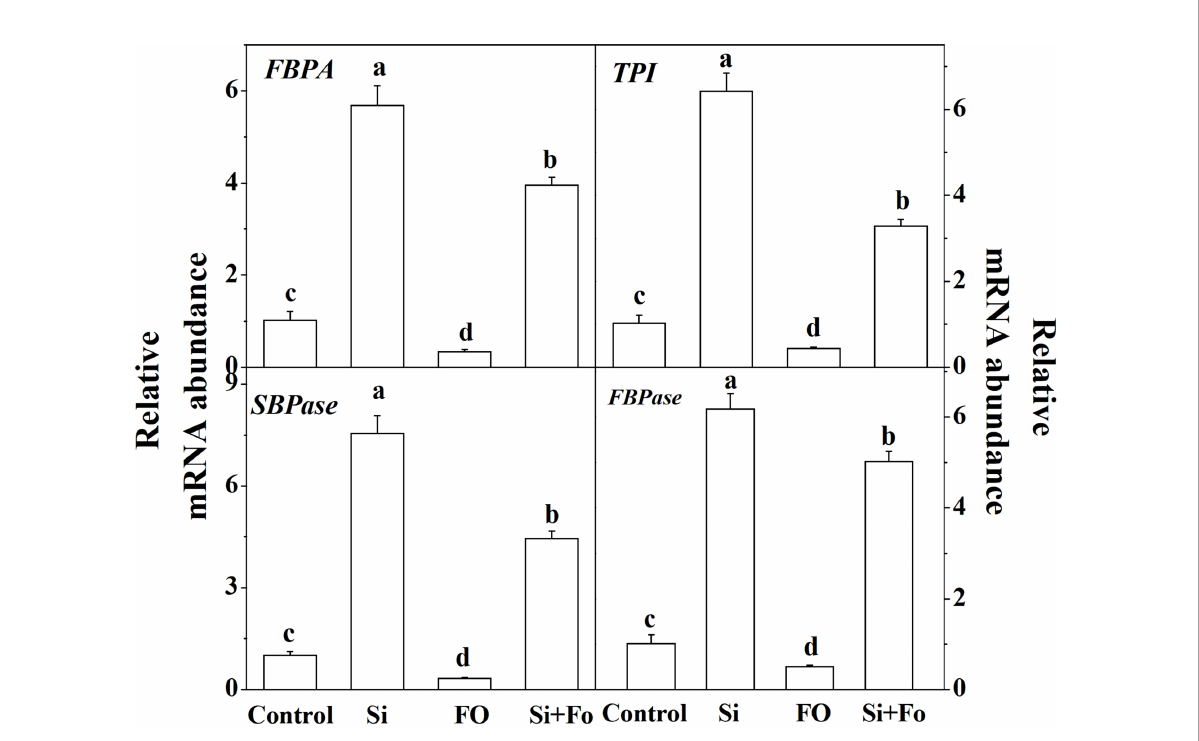
FIGURE 8 Effect of exogenous silicon on the expression of genes involved in the Calvin cycle in tomato leaves. Means denoted by the different lowercase letters are signi fi cantly different according to Tukey ’ s test ( P ≤ 0.05); the mean represents the average of three replicates ± standard deviation (SD). Control: plants were irrigated with sterilized water; Si: plants were irrigated with exogenous silicon (3 mmol·l -1 Si); FO: plants were only inoculated with Fusarium ; Si+FO: plants were irrigated with exogenous silicon followed by inoculation with Fusarium. .